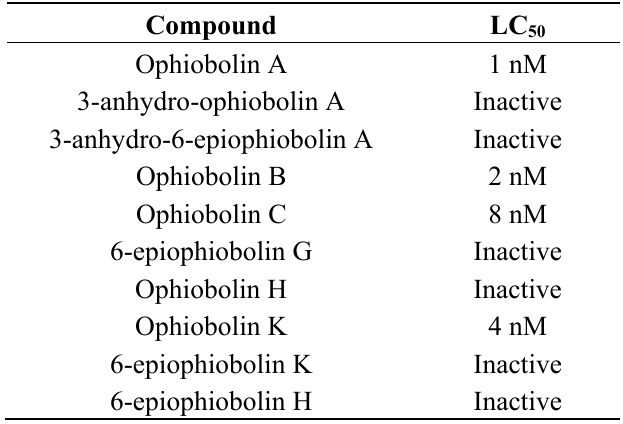
[nM]) of the 10 ophiobolins towards CLL 50